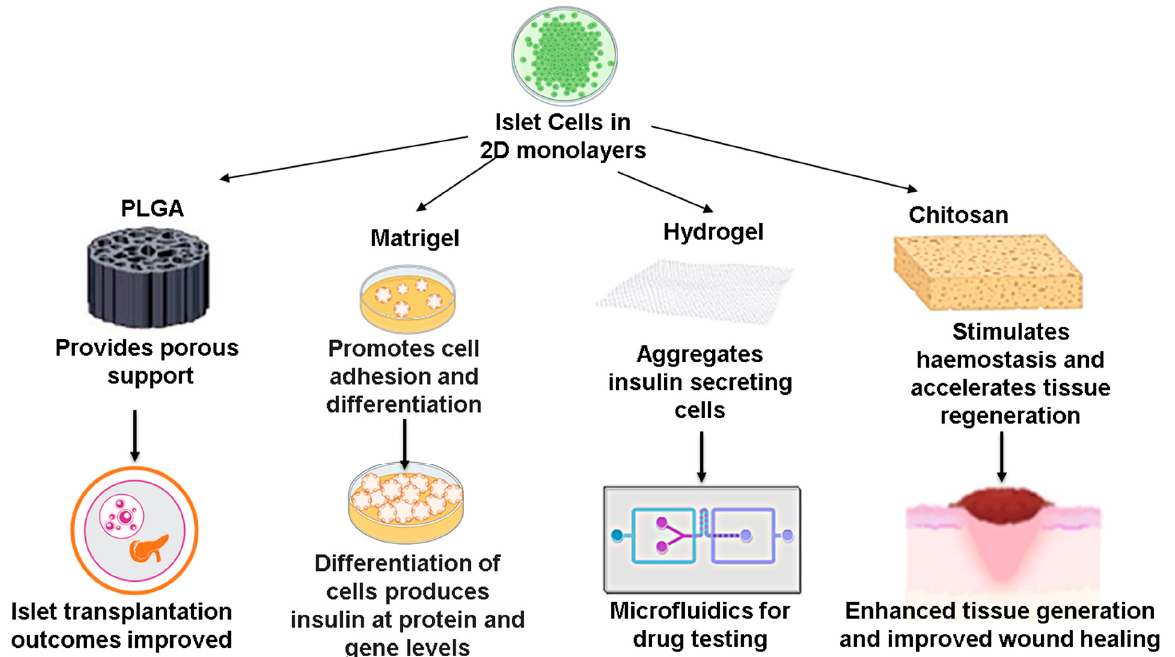
Figure 1. Methodologies to establish pancreatic islet cell scaffolds: Pancreatic scaffolds can be estab- lished using biopolymers arranged to mimic the ECM in the physiological state. Scaffold systems can be synthetic or biological, with porous PLGA, Matrigel, 3D hydrogel matrix, and 3D chitosan scaffolds most commonly used. Incorporating the cells into a structural scaffold-based system promotes the differentiation of stem cells into insulin-producing cells and maintains a glucose stimulation index similar to that of fresh islets. Furthermore, major desirable features such as enhanced insulin and c-peptide release, high drug-screening sensitivity, improved pancreatic transplantation outcome, and elevation in β -cell signature genes are observed in pancreatic β -cells grown on scaffold systems.